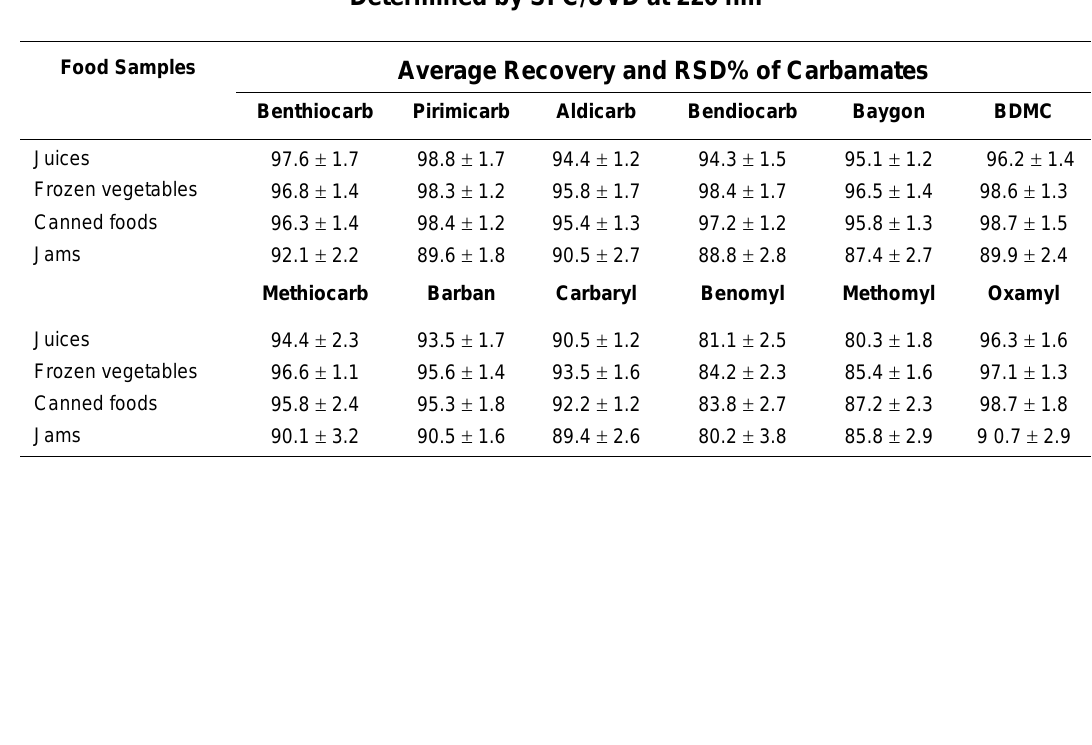
Carbamate Recovery and RSD Percentages of Spiked Food Samples Extracted by SFE and Determined by SFC/UVD at 220